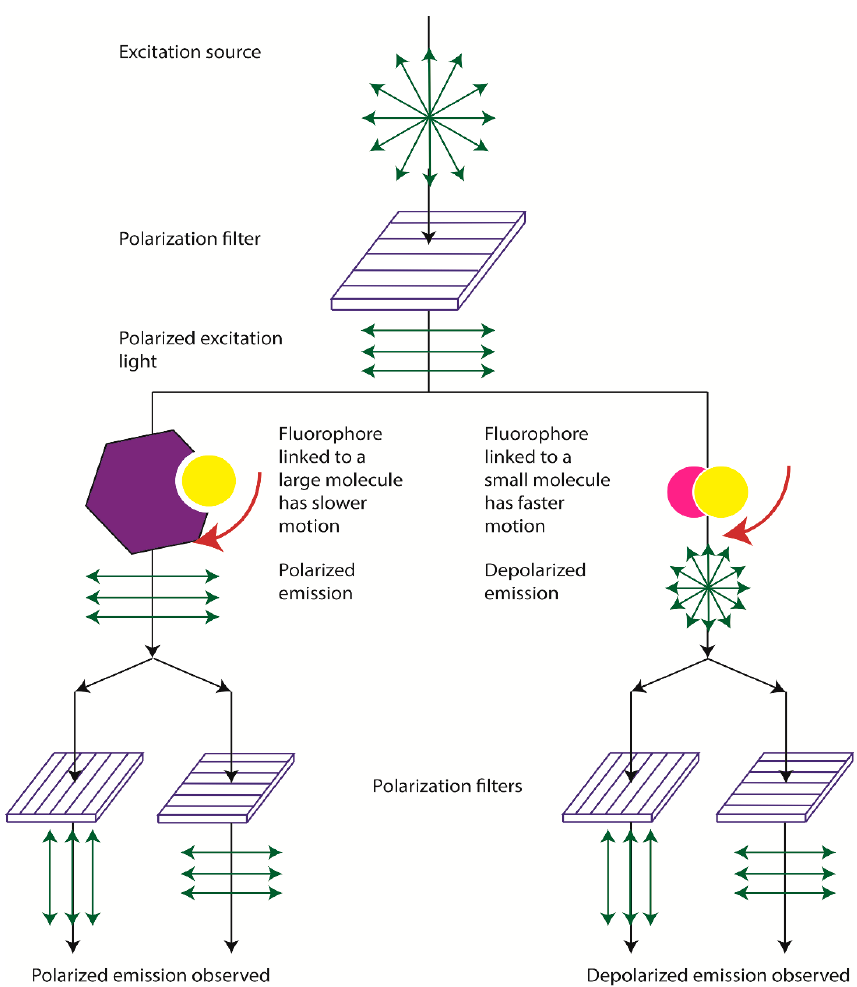
Figure 1. Principle of fluorescence measurement under irradiation with plane-polarized light.